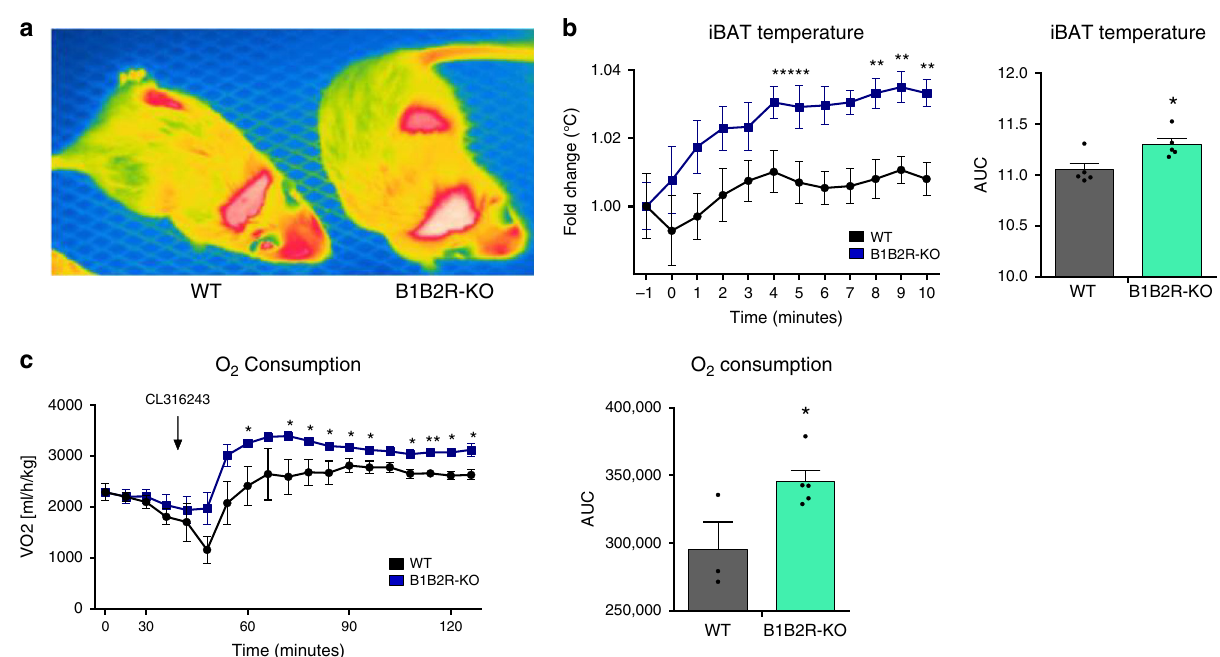
Fig. 7 Effects of CL316243 injection on iBAT temperature and O 2 consumption. a Thermographic image of a WT and B1B2R-KO mouse 4 min after subcutaneous injection of CL316243 in the area of iBAT. b Time course of temperature increase in iBAT after CL316243 injection ( n = 5 animals for PBS and n = 6 animals for B1B2R-KO left graph; n = 5 animals for AUC). c Time course of O 2 consumption after CL316243 injection ( n = 3 animals for PBS and n = 5 animals for B1B2R-KO both graphs). Data are presented as means ± s.e.m. (bars). * P < 0.05, ** P < 0.01 versus corresponding controls; two-tailed unpaired Student ’ s t- test. Source data are provided as a Source data fi